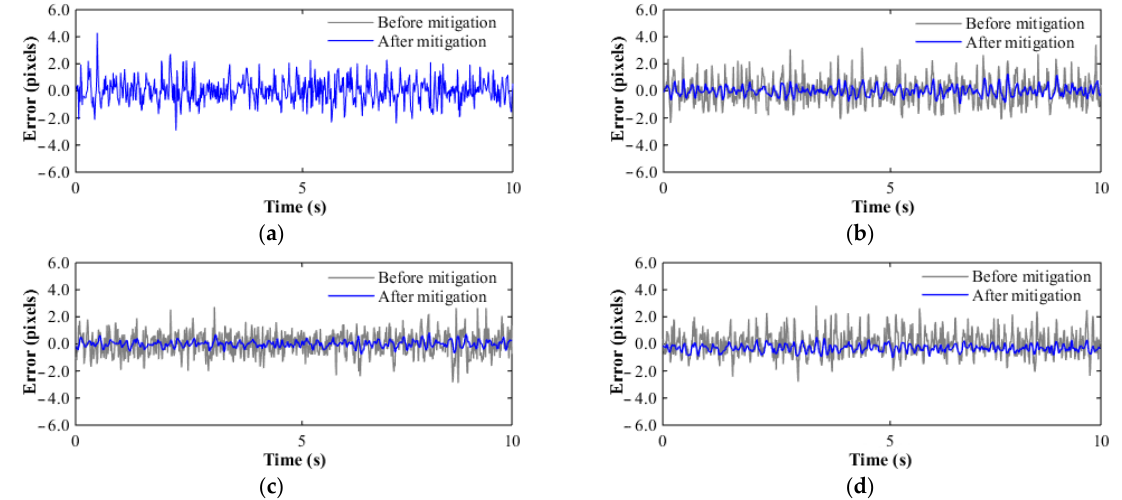
Figure 4. Displacement measurement results before and after optical-turbulence error mitigation. Number of measurement points ( a ) 1, ( b ) 36, ( c ) 256, ( d ) 484.